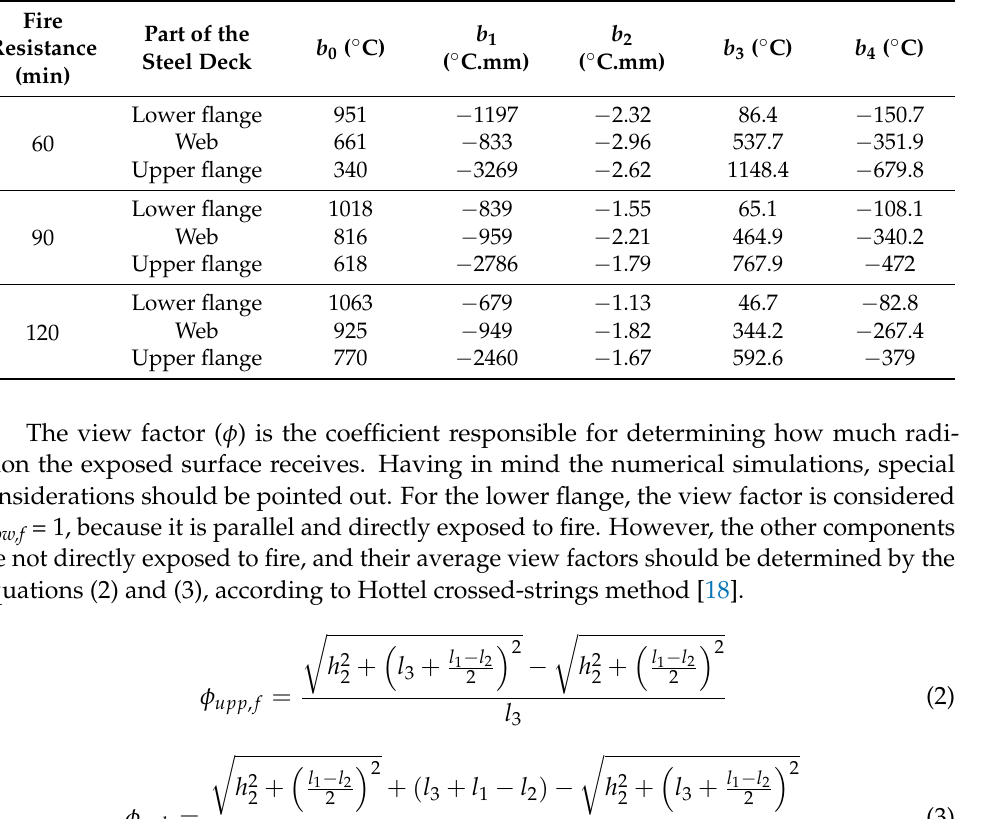
Table 1. Coefficients for the determination of the temperature in steel deck for normal weight concrete